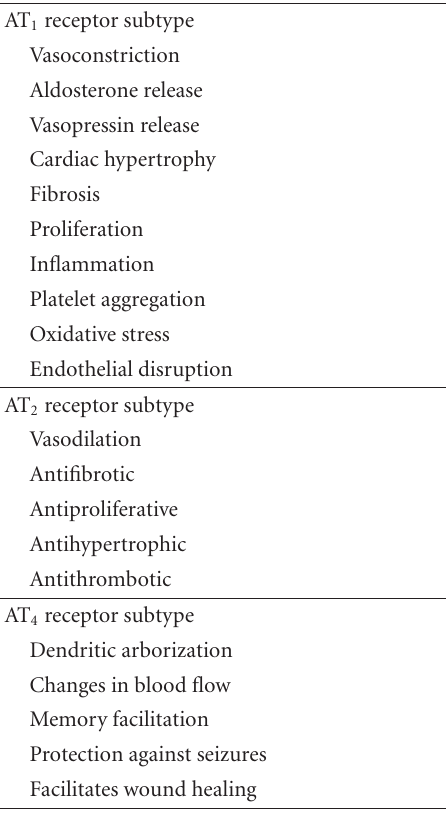
Table 2: Ligand activation of the AT 1 , AT 2 , and AT 4 receptor subtypes influence the following